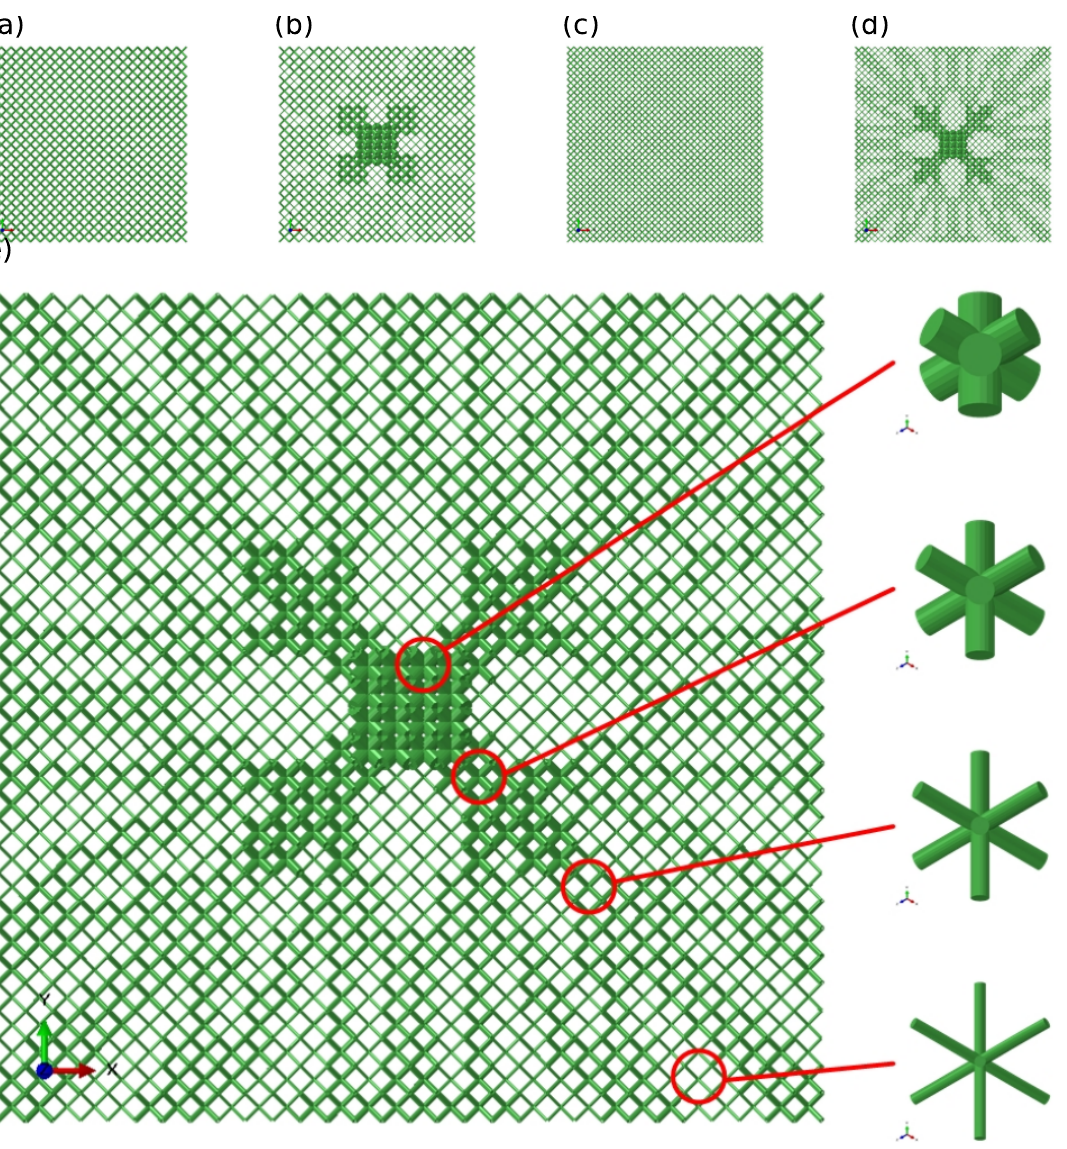
Figure 9. Uniform designs and Bionic designs obtained by mapping methods. ( a , b ) U 1 and B 1 with l cell = 10.0mm. ( c , d ) U 2 and B 2 with l cell = 6.667mm. ( e ) Lattices with different size in B 2